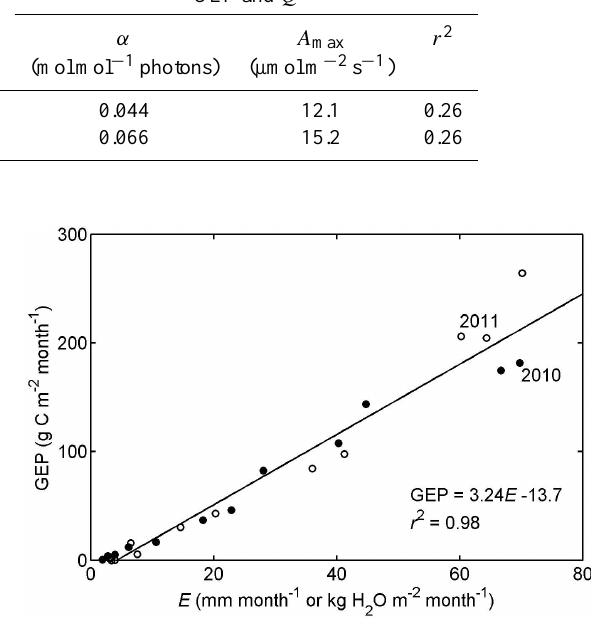
Fig. 8. Light-response curve showing gross ecosystem photosynthe- sis (GEP) plotted against downwelling PAR ( Q ) for 2010 and 2011. Each data point is an average of 50 half-hour values. The equation parameters are given in Table 4.